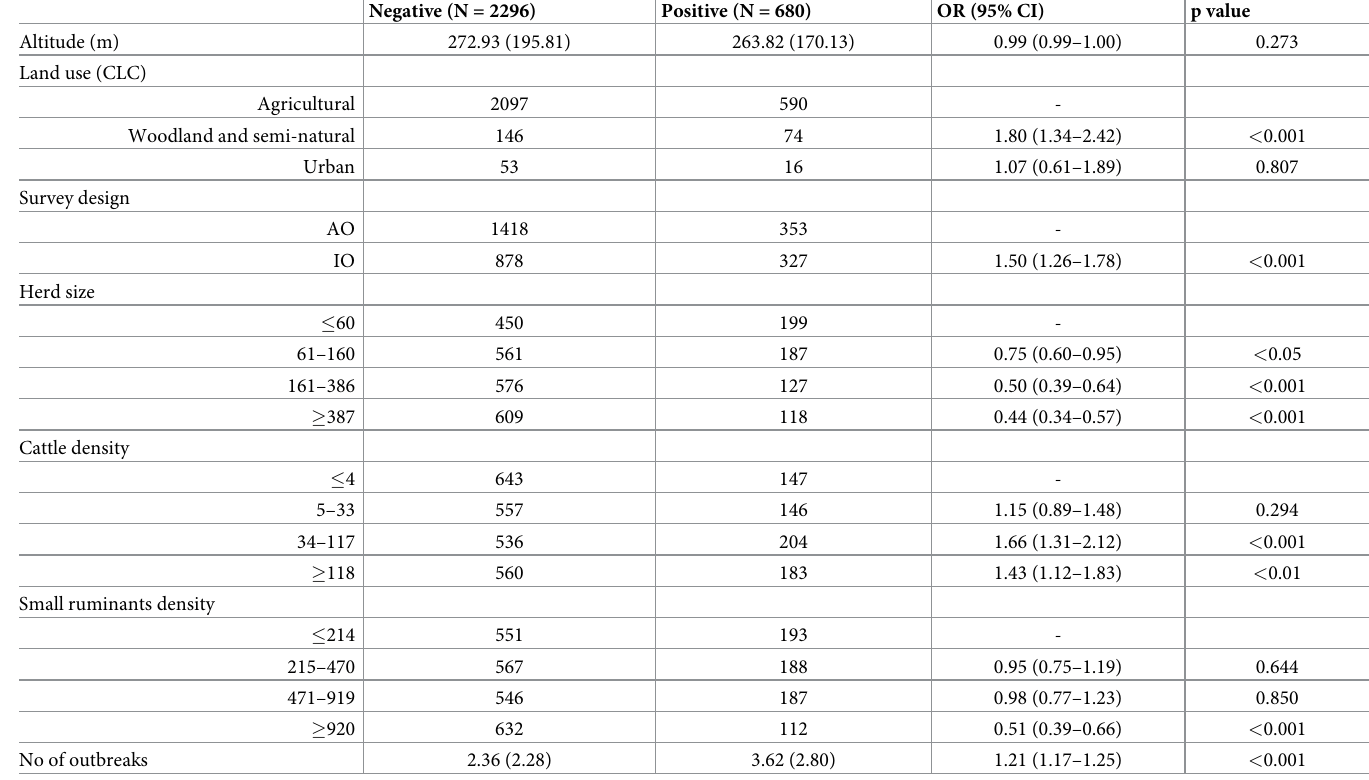
Table 3. Univariable analysis for the exposure variables relative to the animal seropositivity